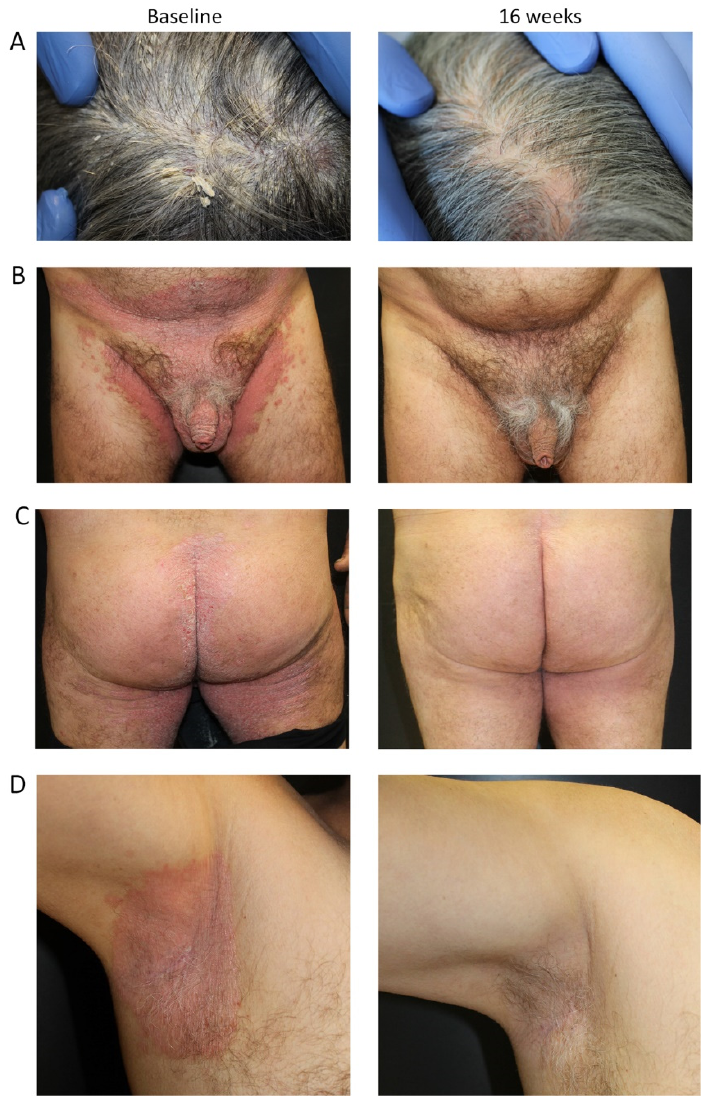
Figure 3. Representative images of outcome in Case #2; male patient with psoriatic lesions of the scalp ( A ), genital lesions ( B ) and involvement of intertriginous areas (gluteal; ( C ) and armpit; ( D )). After 16 weeks of treatment with tildrakizumab, all outcome measures (PASI, sPGA-G and PSSI) decreased to 0.